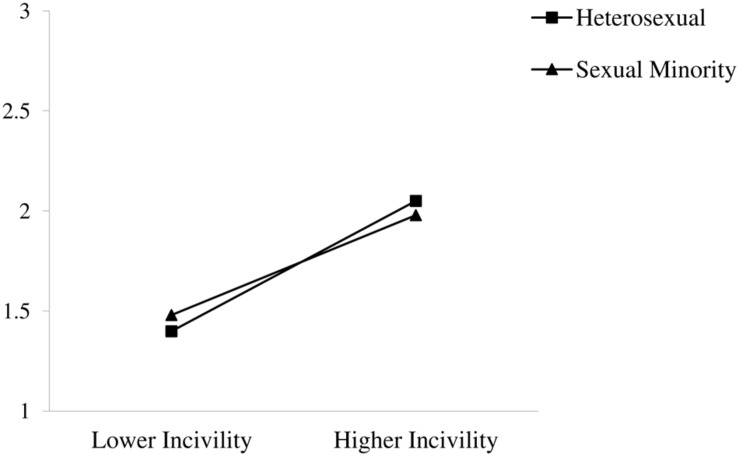
Interaction of workplace incivility and sexual orientation on job stress.